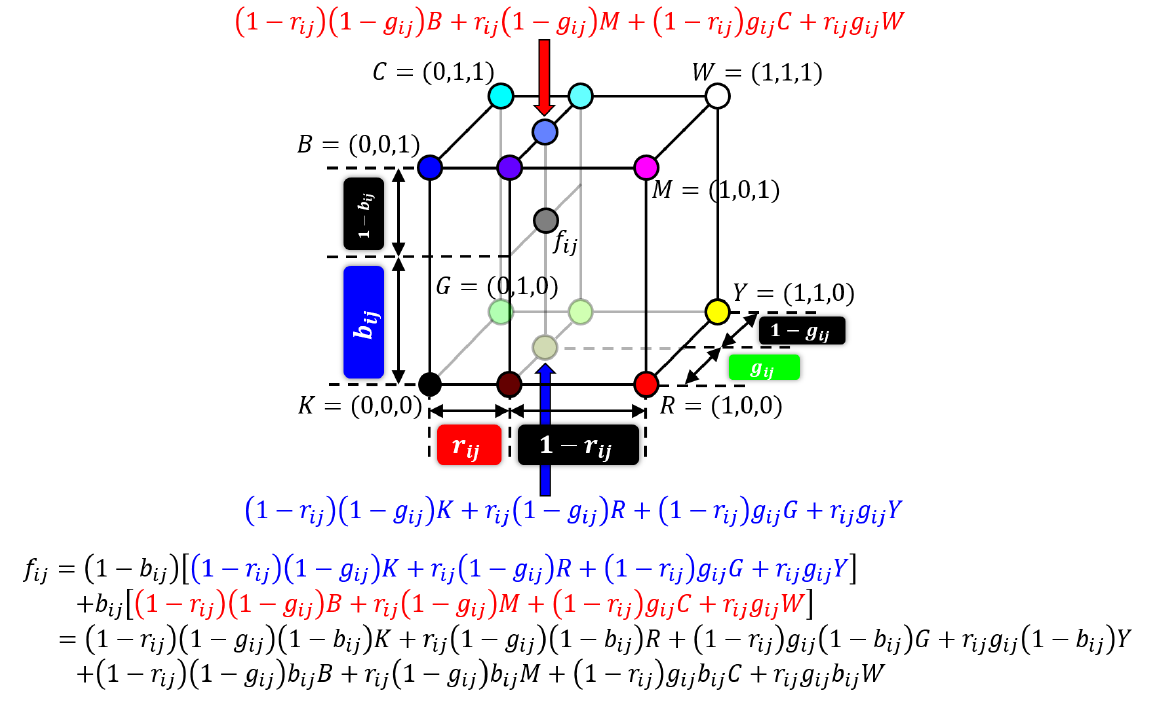
Figure 4. Three-dimensional Neugebauer